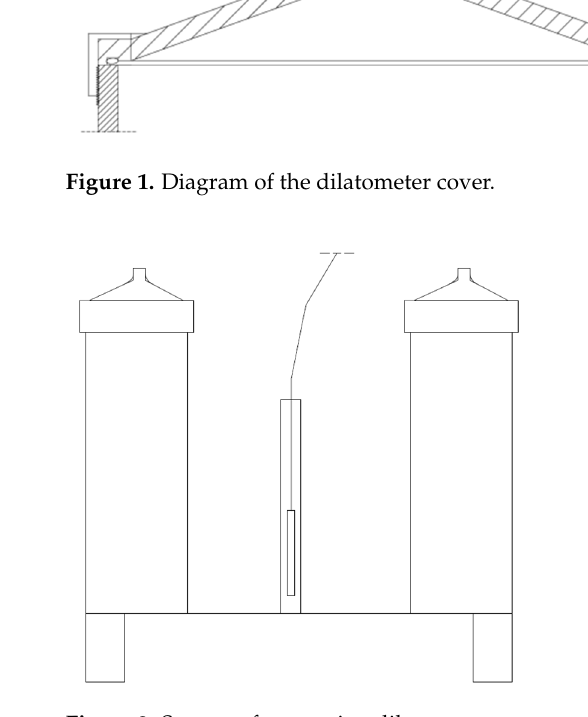
Figure 2. System of measuring dilatometers.